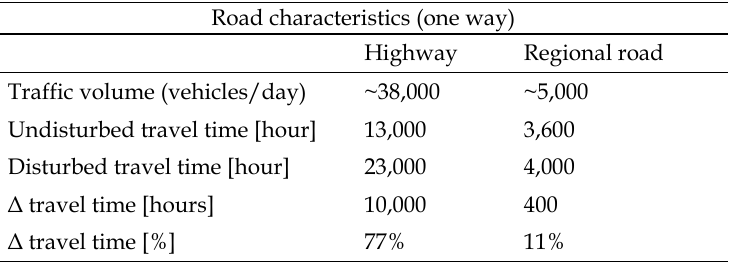
Input and output of quick scan tool for extra travel time due to flooding of a tunnel in a highway and a regional